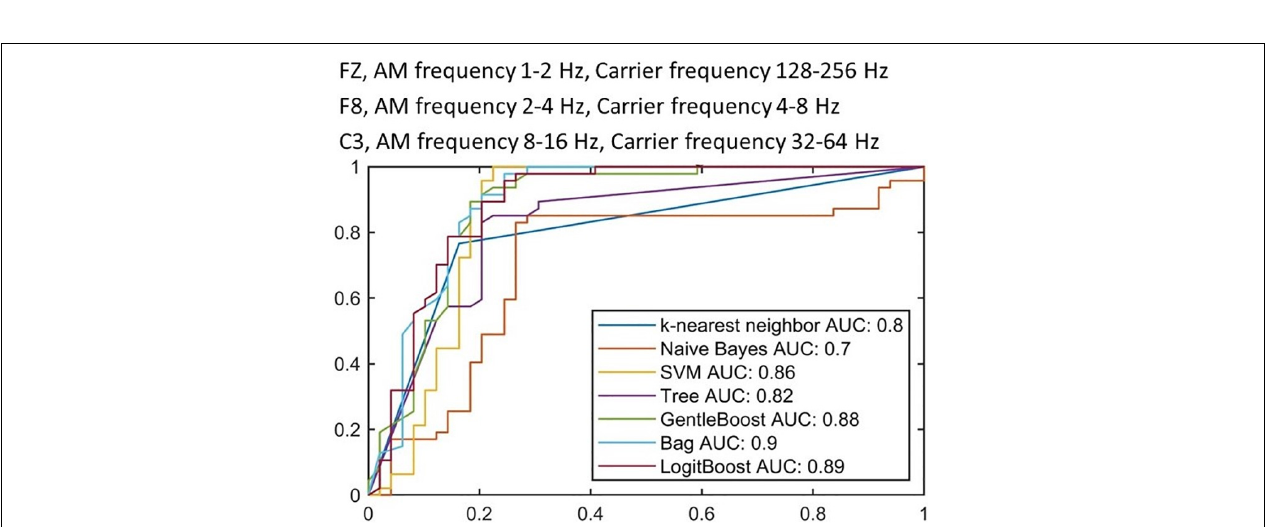
Frontiers in Aging Neuroscience |